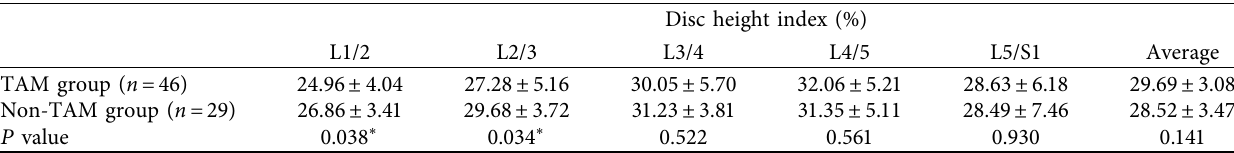
Table 3: Comparisons of the lumbar disc height index for each lumbar disc and the average